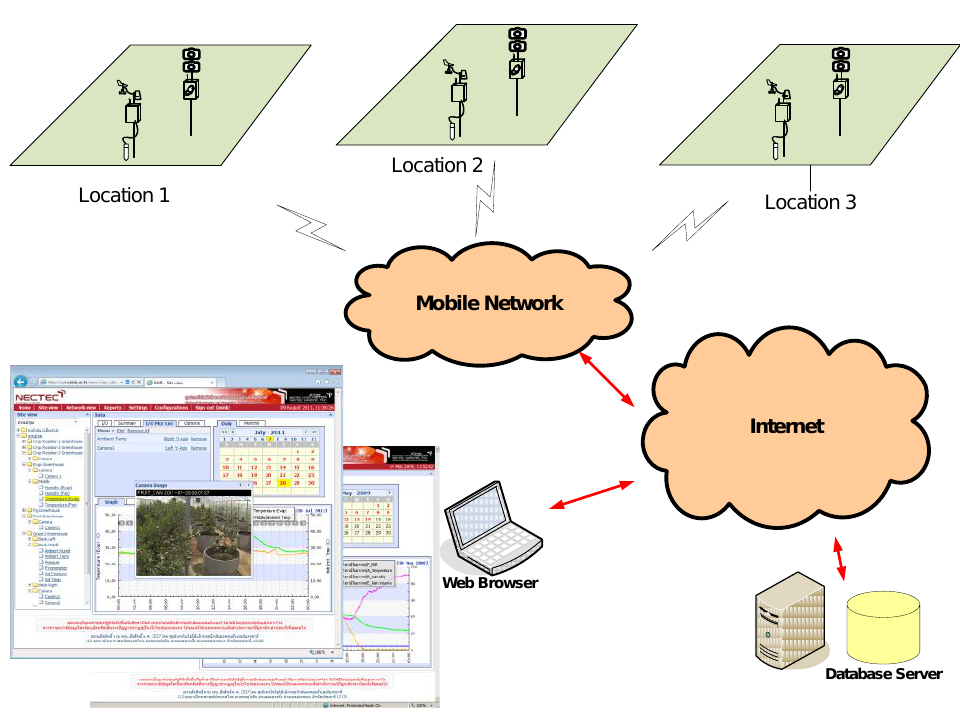
Figure 1. Field server